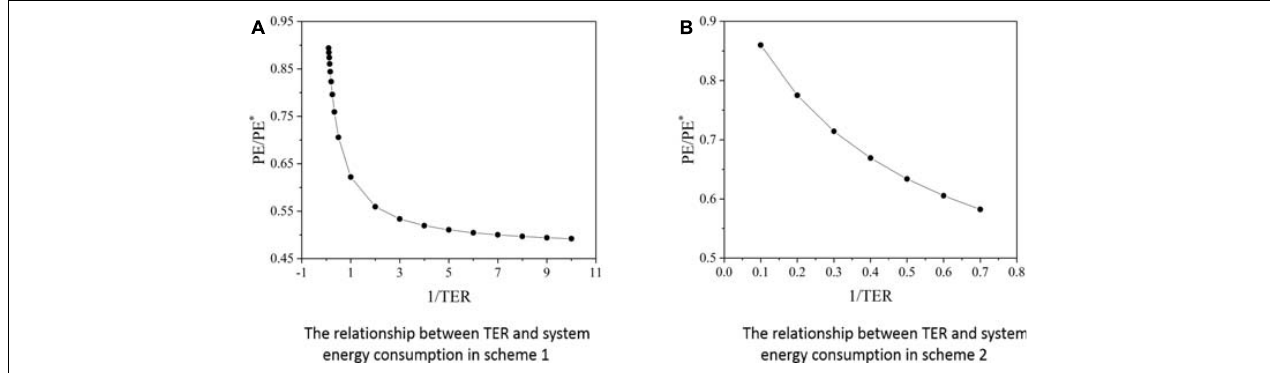
FIGURE 12 | Influence of user’s TER on system energy saving. (A) The relationship between the TER and the system energy consumption in scheme 1. (B) The relationship between the TER and the system energy consumption in scheme 2.